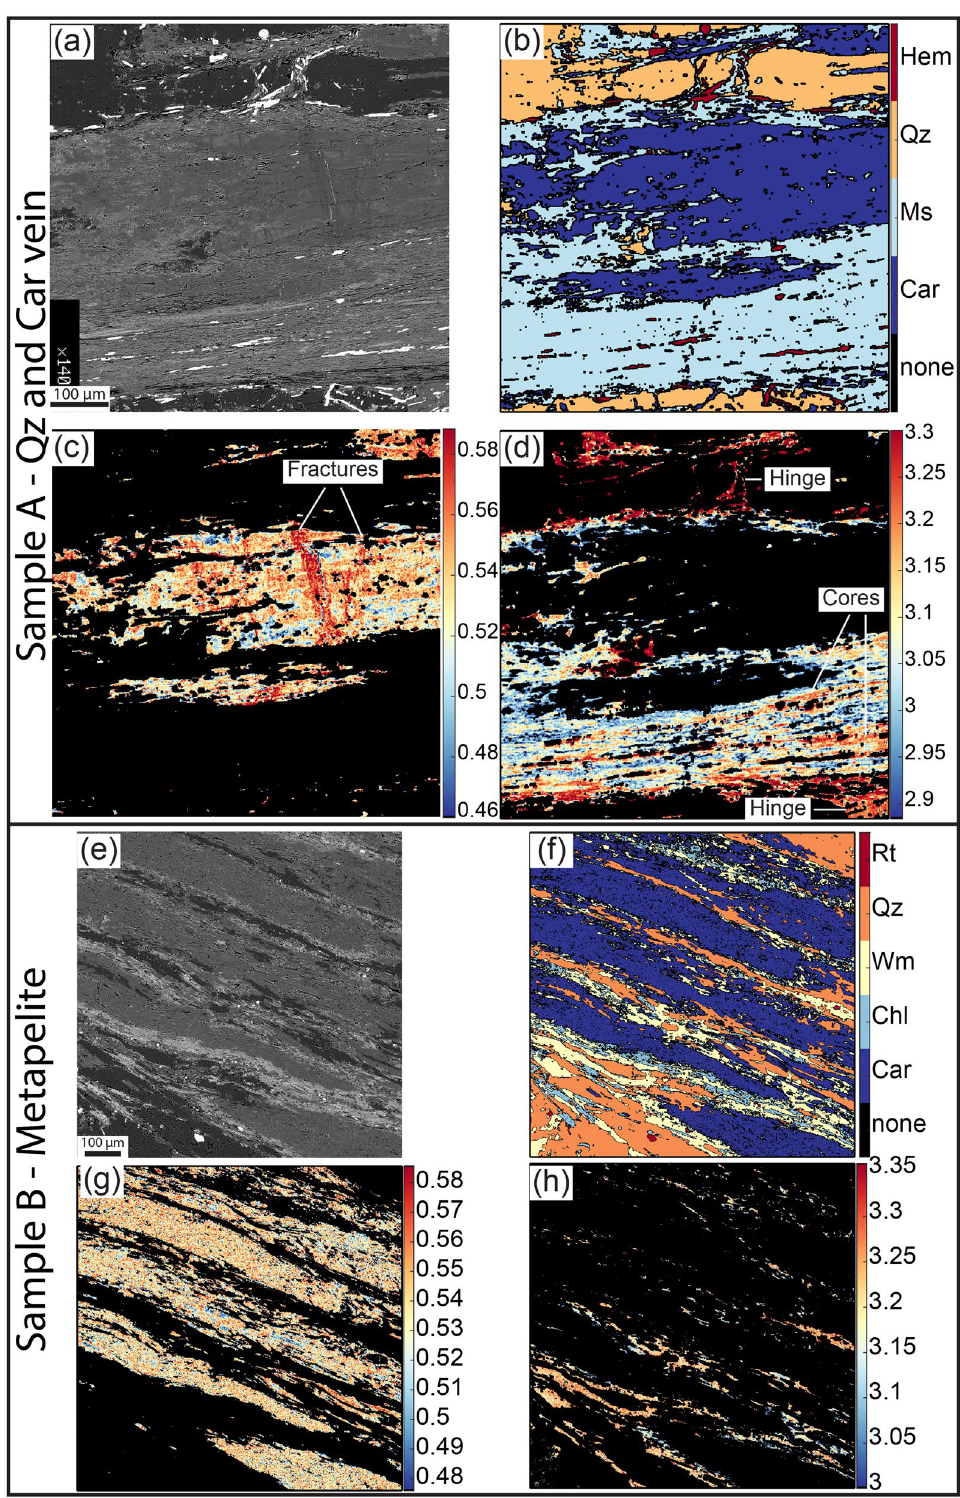
Figure 7. Chemical data from mineral phases infilling the dilational hydroshear veins and defining the mylonitic foliation. ( a – d ) Details of Fig. 3d,e. ( a ) BSE image showing fractures perpendicular to the carpholite fibre sealed by darker carpholite (compare with b and c ). ( b ) X-ray compositional map, colour coded for the different mineral phases. ( c ) Standardised X-ray map of the X Mg (X Mg = Mg/(Fe 2+ + Mg) in carpholite. Note the fractures oriented perpendicularly to the lengthening of the grain sealed by a second generation of carpholite with higher X Mg . ( d ) Muscovite Si apfu map highlights two muscovite generations: the first with higher values located in the core of the grains and in fold hinges and the second with lower values at grain boundaries. ( e – h ) Details of Fig. 3h,i. ( e , f ) BSE image and X-ray compositional map displaying a foliation marked by carpholite, muscovite and quartz, with chlorite growing at grain boundaries and marking retrogression. ( g ) Carpholite X Mg map. ( h ) Muscovite Si apfu map. The lower values are located in proximity of chlorite